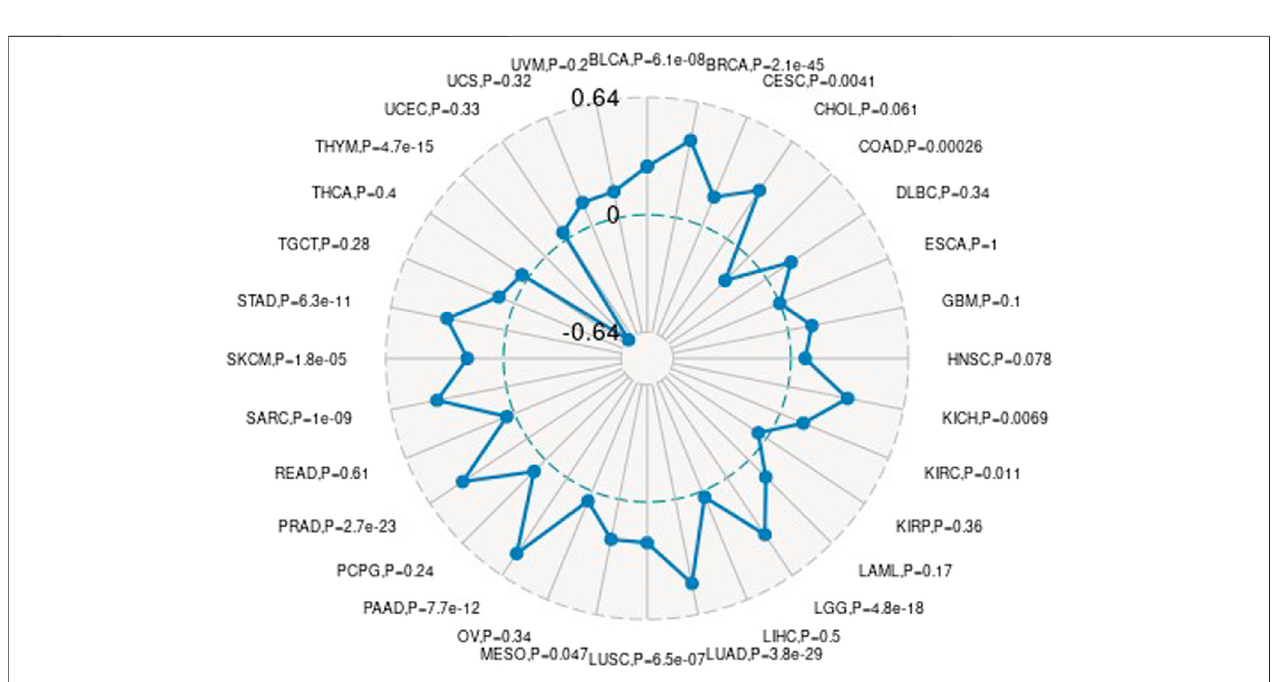
FIGURE 11 | The relationship between gene expression and TMB.